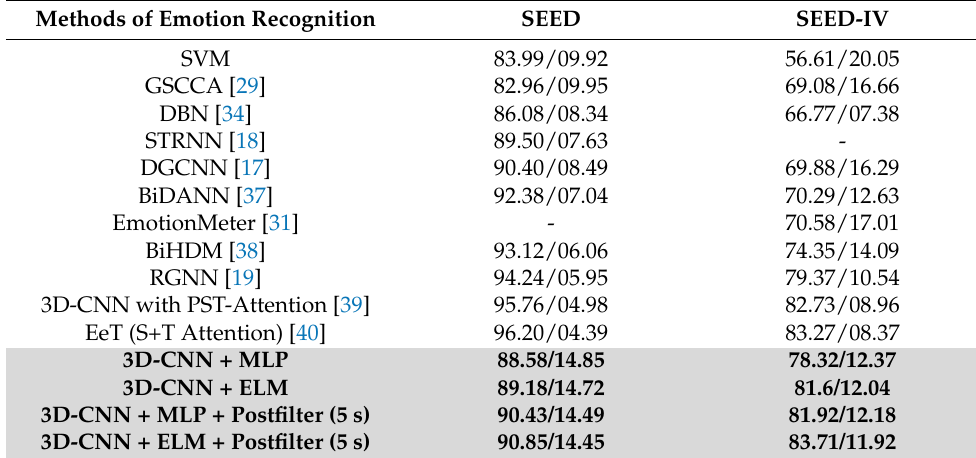
Table 9. Performance comparison between different relevant studies on SEED and SEED-IV datasets. The numbers in the table are the best accuracy that the study achieved.